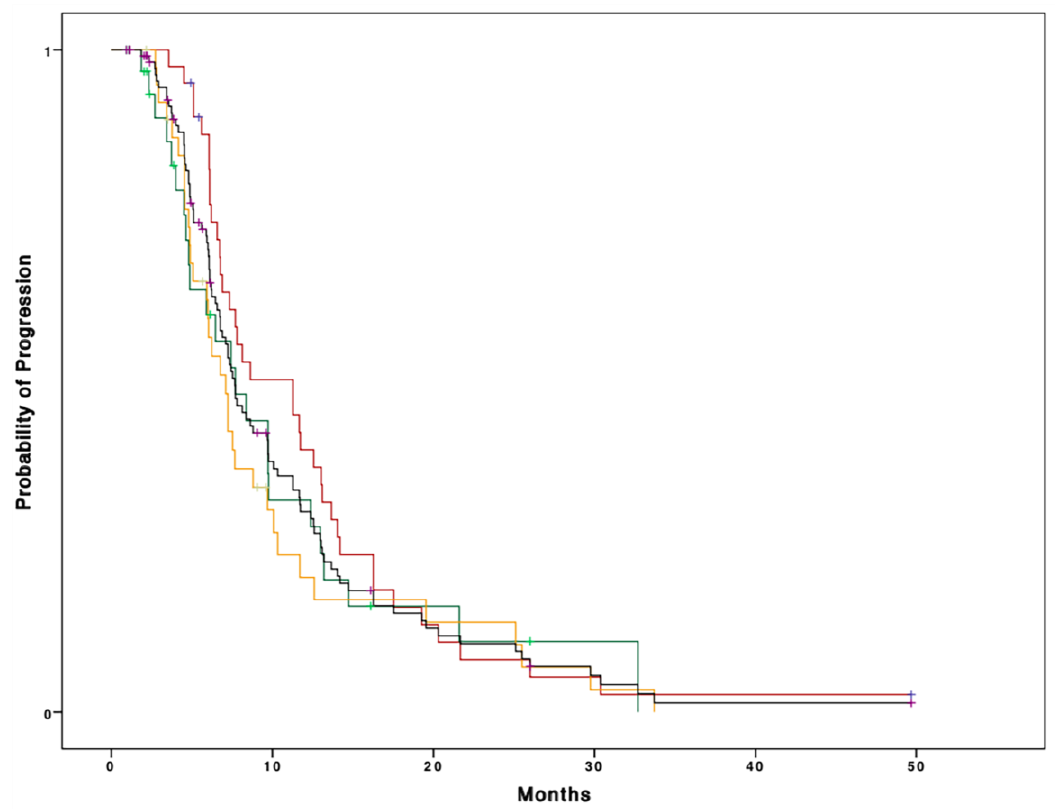
Figure 2. Kaplan–Meier curve representing the PFS according to CGA categories (fit patients: red line; vulnerable patients: green line; frail patients: orange line; whole population: black line).